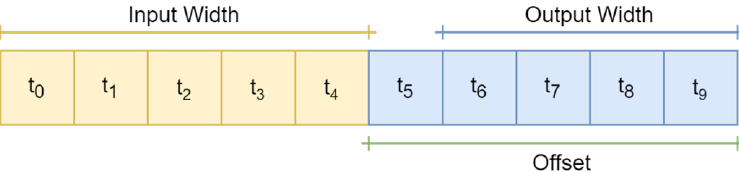
Figure 6. Data windowing: in this example, input width is 5, output width is 4, and offset is 5.